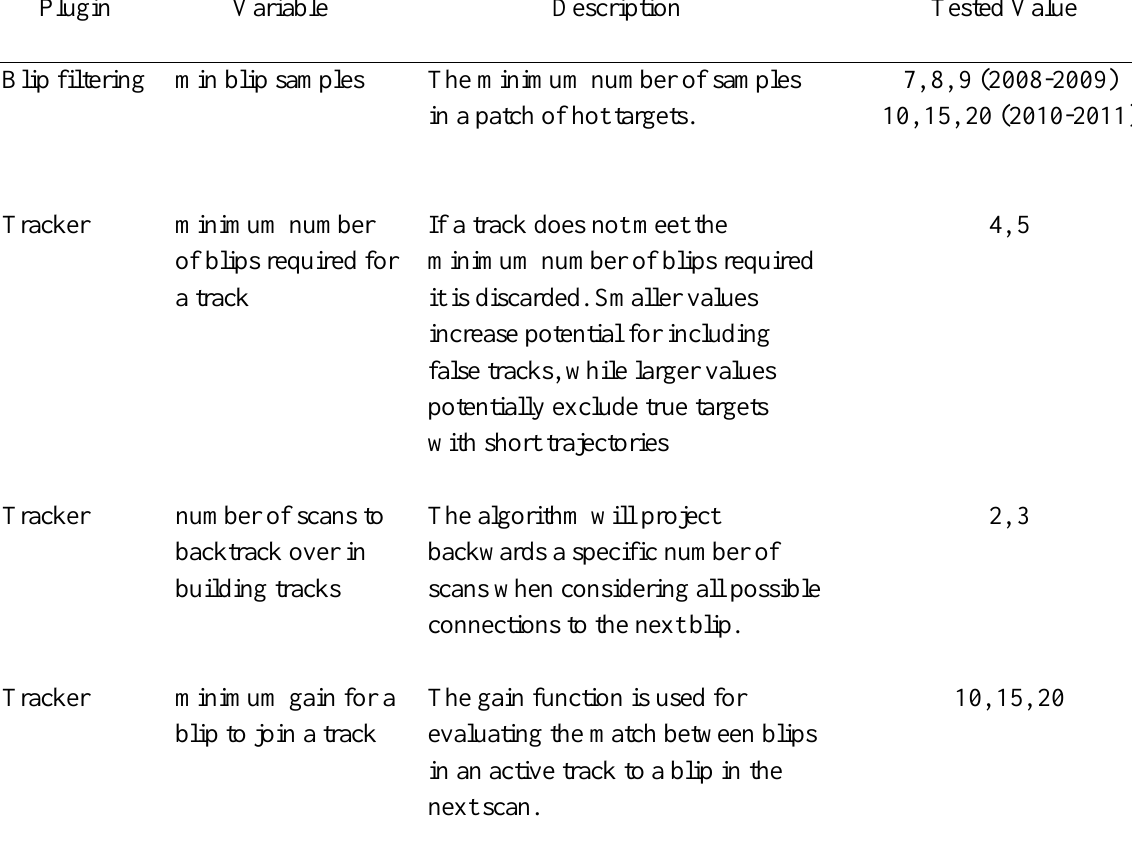
Table A1.1. Variables adjusted within radR for autodetection and tracking of avian targets from radar recorded with the XIR3000B signal processor. Variation in the tested value for blip filtering is due to upgrades with the WinHorizon software from 1024 to 4096 scan lines in